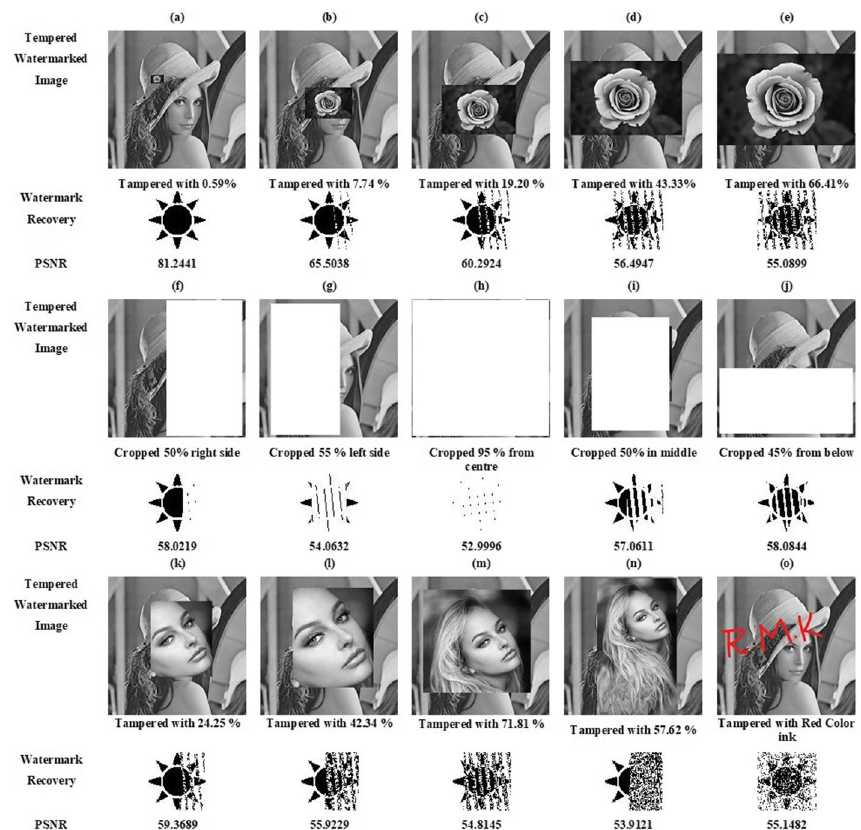
Fig. 8 Recovery of watermark from tampered watermarked images for image